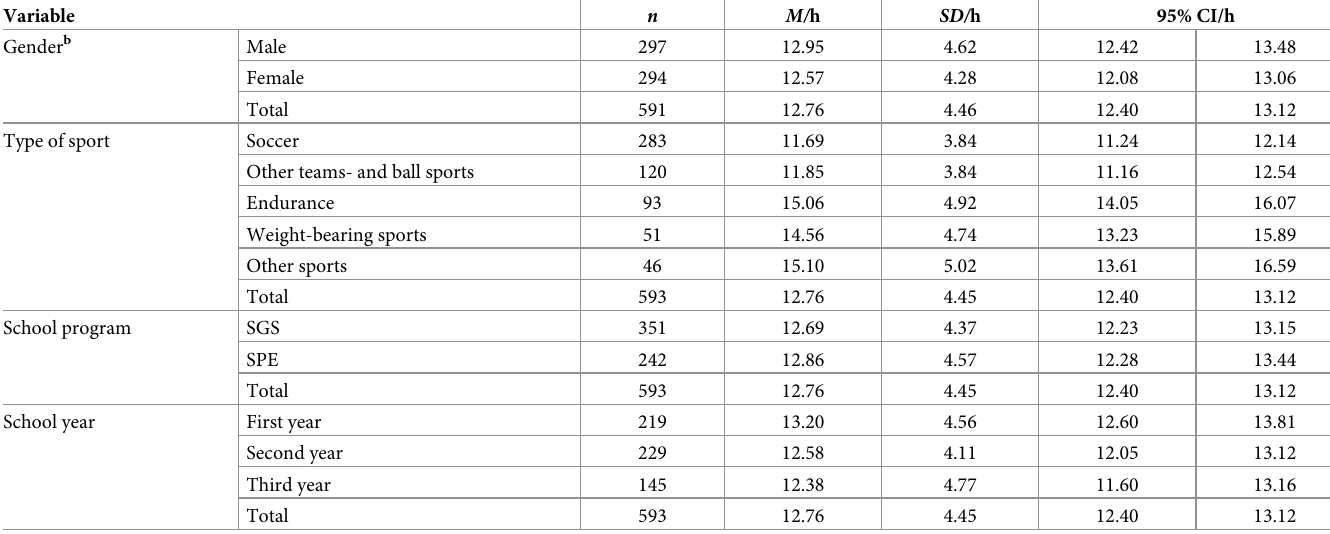
SGS = Specialization in general studies; SPE = Sports and physical education; n = sample size; M = mean; SD = standard deviation; CI = Confidence interval; h = hours. a 15 missing values were observed for training volume. b 2 missing values were observed for